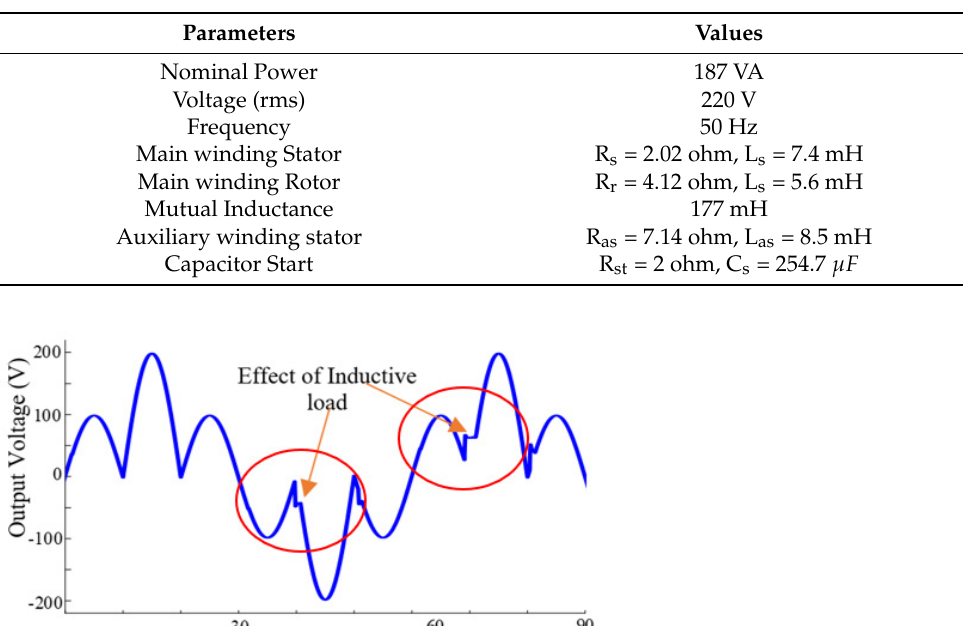
Figure 10 . Harmonics spectrum of one − third frequency conversion of input frequency for motor load: ( a ) voltage; ( b ) current.